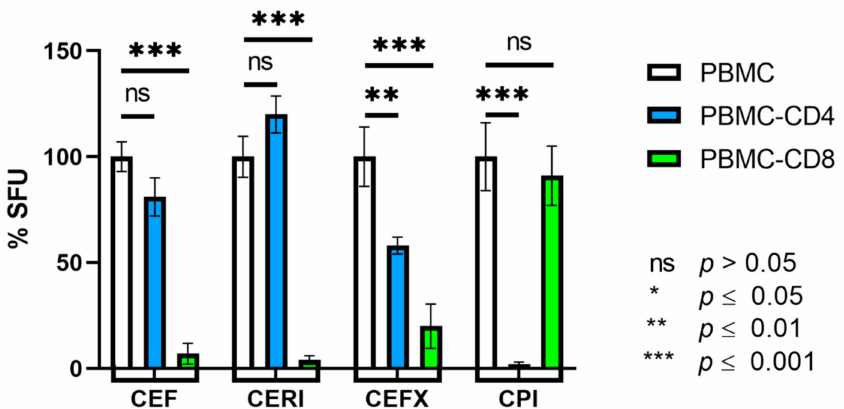
Figure 1. Identifying the CD4/CD8 lineage of T cells responding to antigens CEF, CERI, CEFX, and CPI. The SFU counts in the unseparated PBMC was set as 100%, to which the SFU counts in the CD4 cell-depleted PBMC (PBMC-CD4 that still contain the CD8+ T cells) and the CD8 cell-depleted PBMC (PBMC-CD8 that sill contain the CD4+ T cells) are compared. PBMC, PBMC-CD4, and PBMC-CD8 were all adjusted to 300,000 cells/well. The PBMC tested were from Donor ID 162 and the 100% SFU counts for the CEF, CERI, CEFX, and CPI-responses in the unseparated PBMC were 195, 266, 400, 486, SFU, respectively. For each experimental condition, means and standard deviations calculated from triplicate wells are shown, and an independent samples student’s T -test was done to detect significant differences between the specified